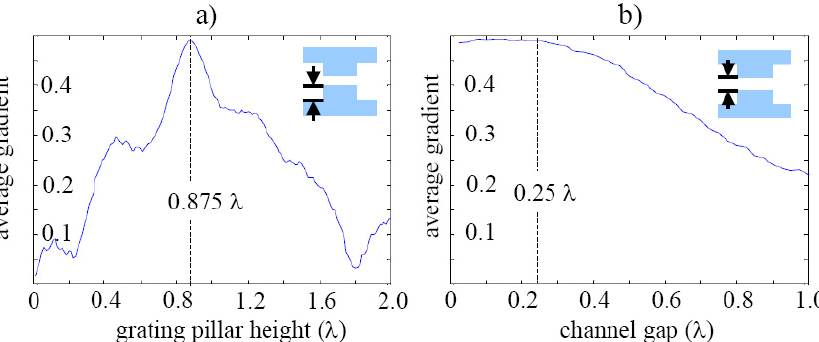
FIG. 4. (Color) (a) Average energy gradient versus grating pillar height. The value of the gradient corresponds to an input plane-wave (cid:4) 1 . (b) Average gradient versus vacuum channel gap at the narrow region of the channel. The pillar field with an amplitude of E 0 height for this plot corresponds to 0 : 9 (cid:3)